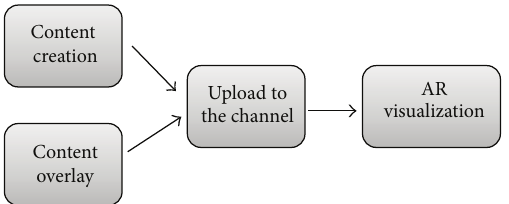
Figure 3: The general scheme of dUcale AR demo.